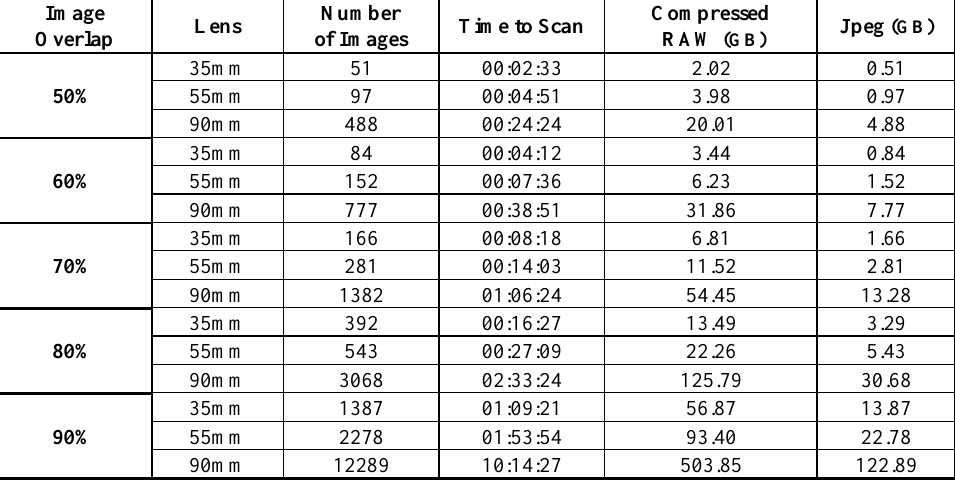
Table 2. Results of preliminary virtual